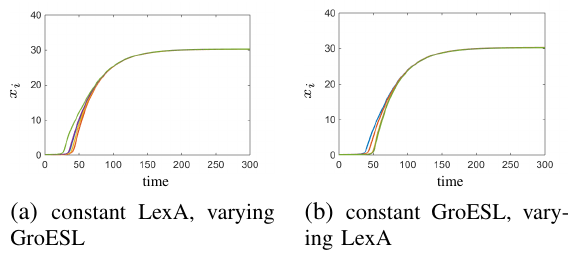
Fig. 10: Time course of the intracellular AHL- concentration of ten cells within one colony influenced by GroESL and